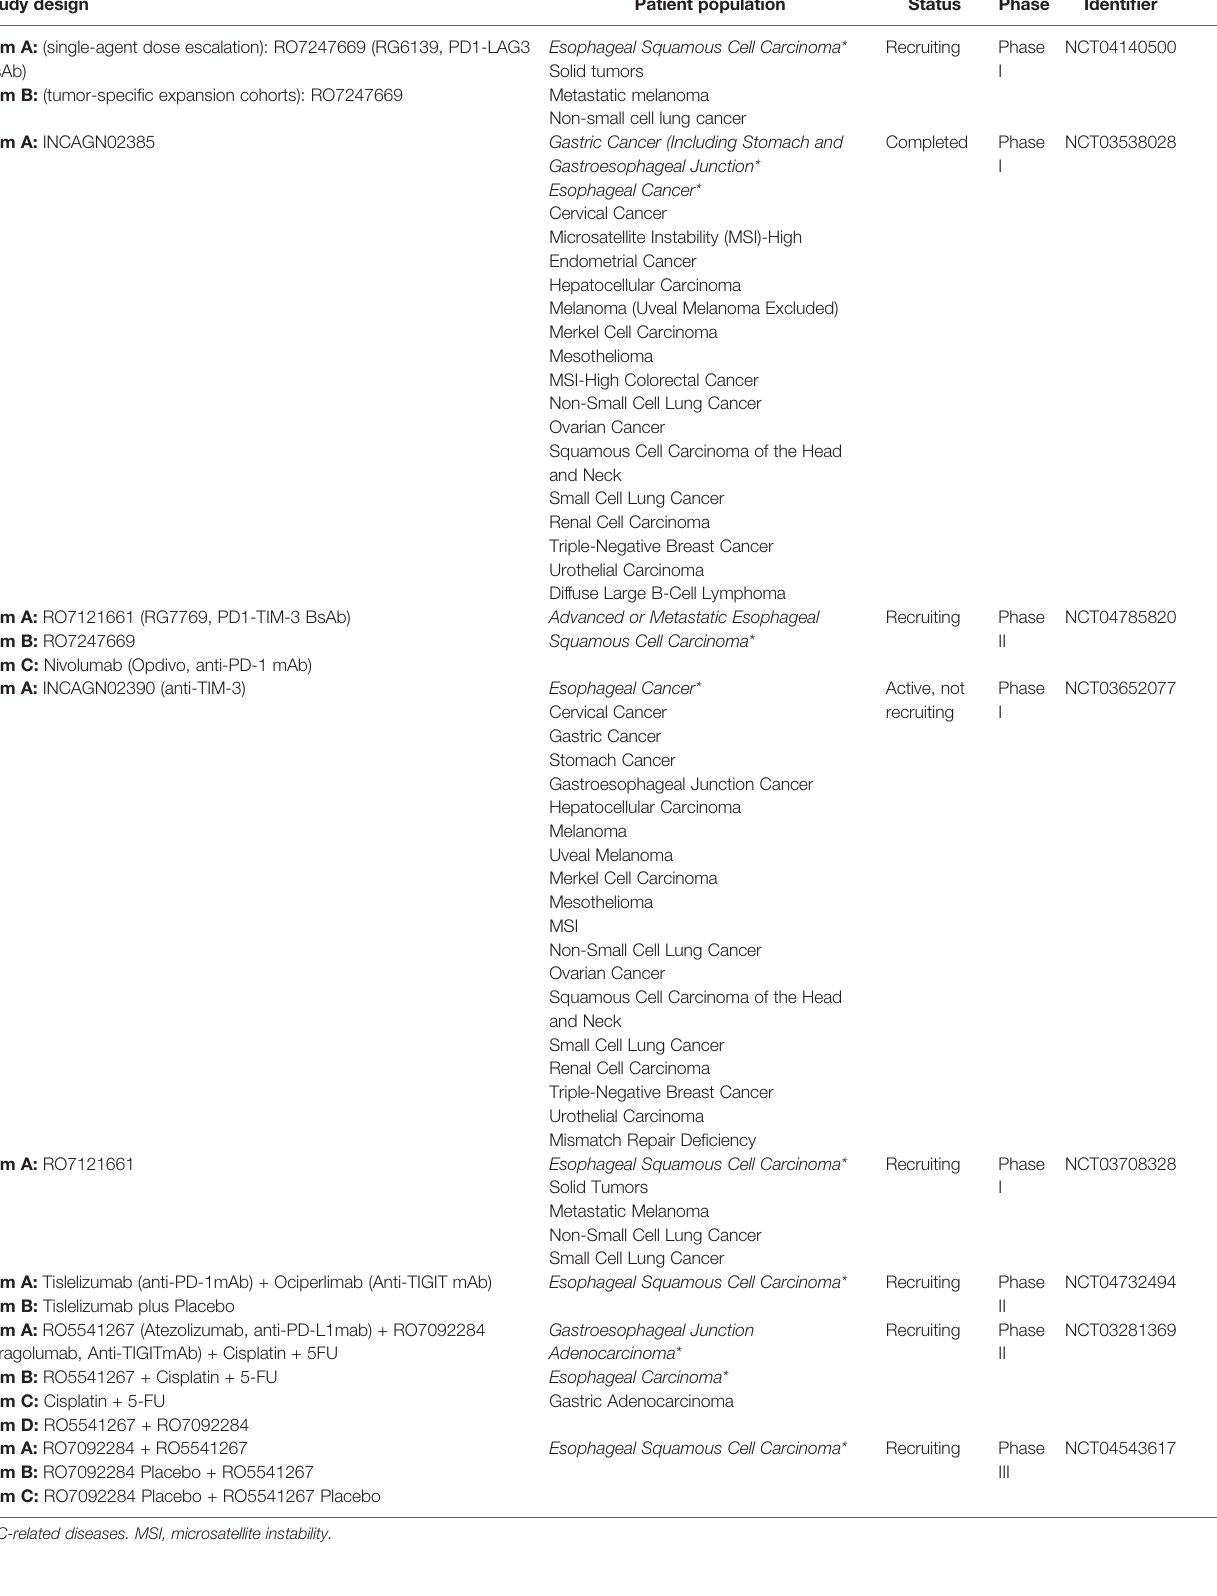
TABLE 2 | The ongoing clinical trials evaluating ICIs targeting novel immune checkpoint pathways in